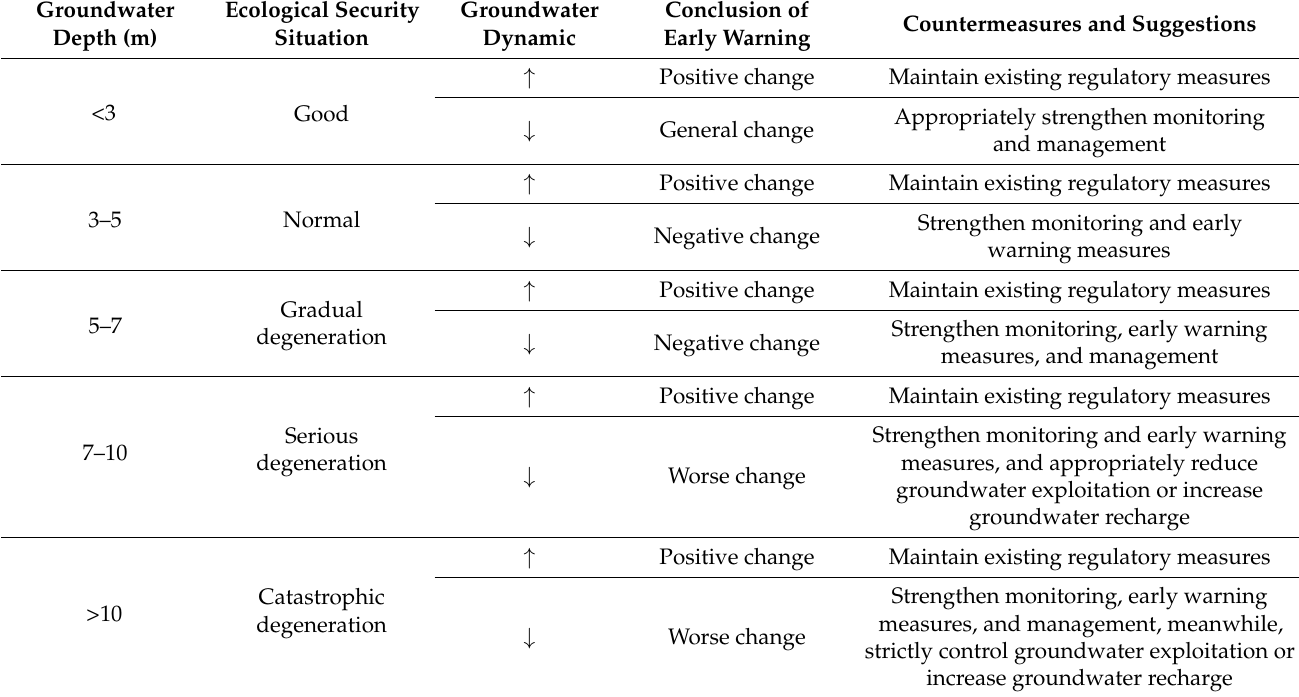
Table 4. Ecological security early warning and management threshold index system of natural vegetation